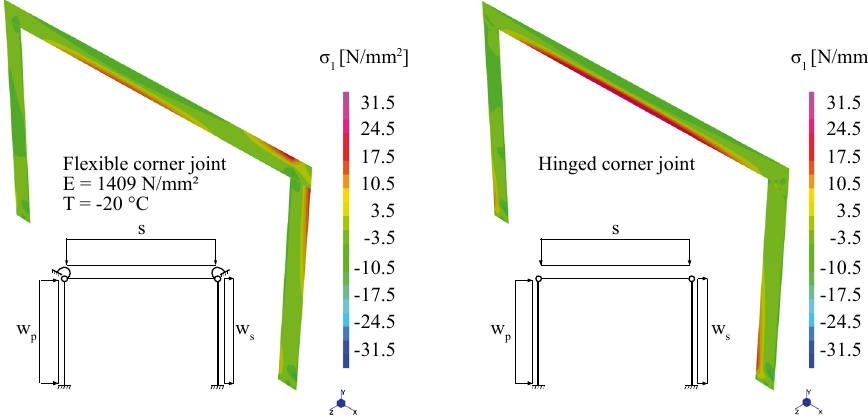
Figure 3: Stress distribution for different states of the structural system.